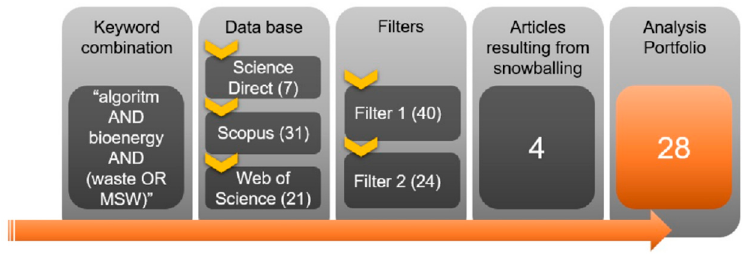
Figure 1. Portfolio analysis composition.